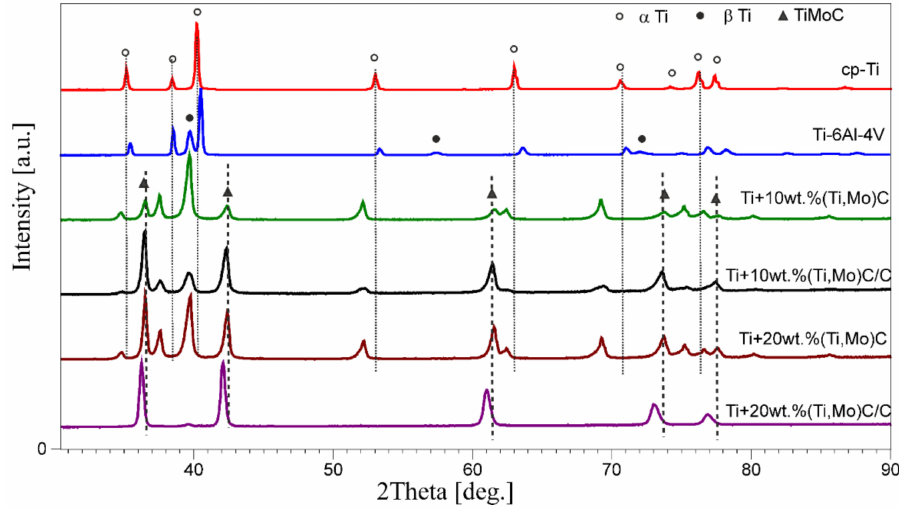
Figure 10. Comparison of the X-ray diffraction patterns of the cp-Ti, Ti6Al4V alloy and Ti + (Ti,Mo)C and Ti + (Ti,Mo)C/C composites after the SPS